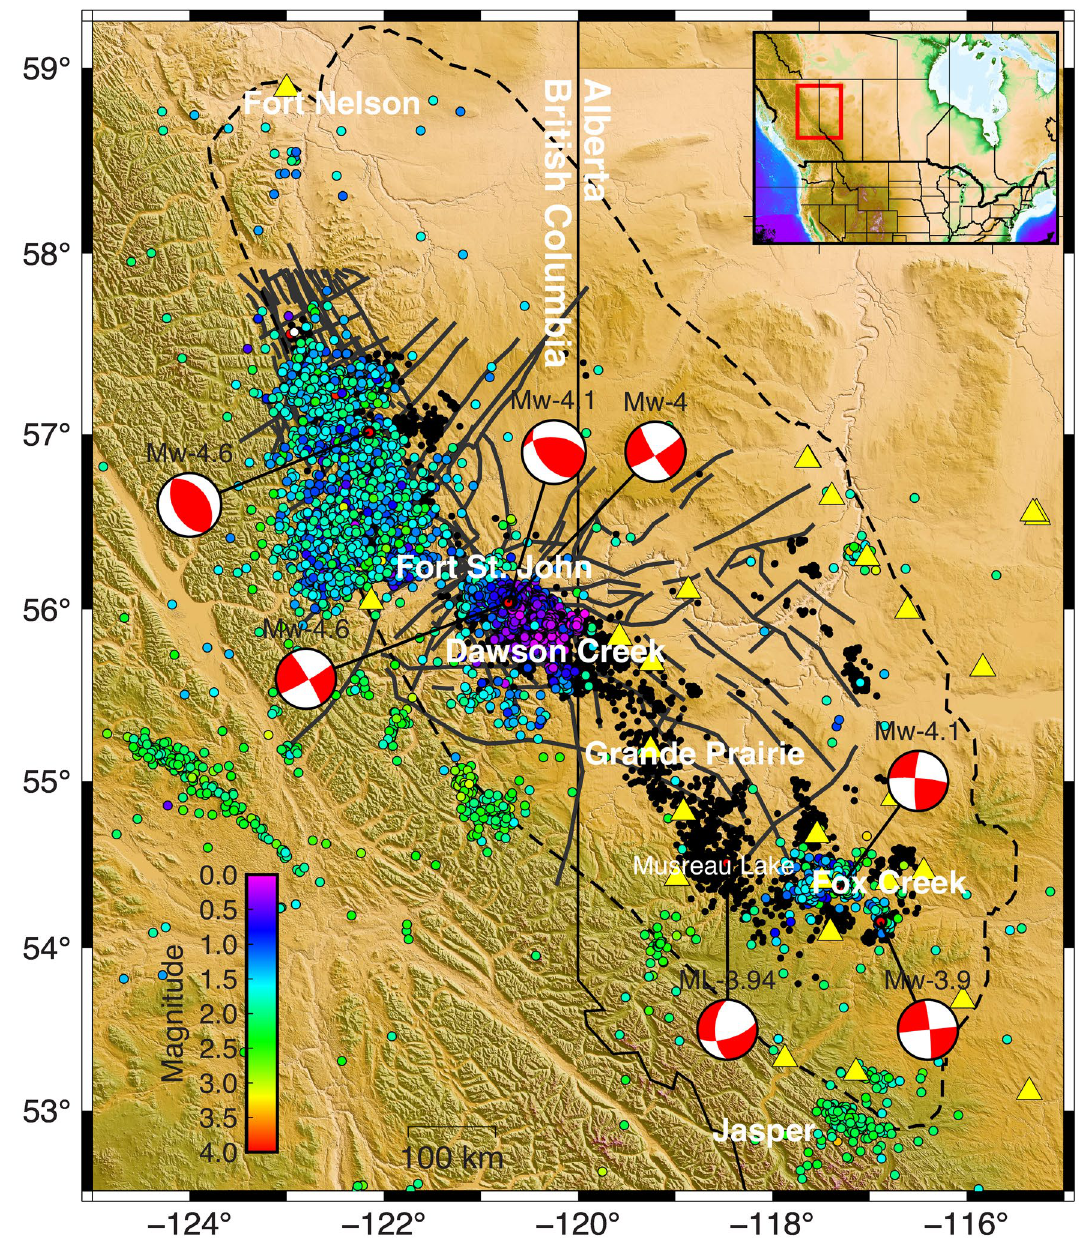
Figure 1. Seismicity, fault traces, HF wells in the Montney Formation. The dashed line defines the Montney Formation area. The colored circles are seismicity reported by Visser et al. 34 and Visser et al. 8 . Not all these earthquakes are within the Montney Formation; the colored circles outside of the area of the Montney Formation are natural tectonic earthquakes. The earthquakes around Fox Creek have resulted from HF in the Duvernay Formation and wastewater disposal near Musreau Lake (event ML 3.94) 35 . Grey thick lines are the main faults in the studied area. Black dots show wells drilled into the Montney Formation. Geographical locations of seismic stations are indicated by yellow triangles 36 . The mechanism events represent some major earthquakes recorded in the area. The figure was generated using the Generic Mapping Tools (GMT) V.6 37